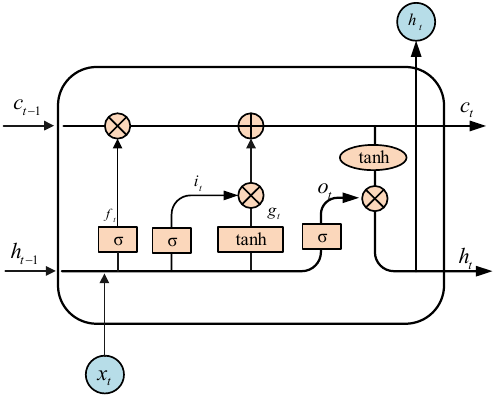
Figure 9 . LSTM unit structure. Figure 9. LSTM unit structure.